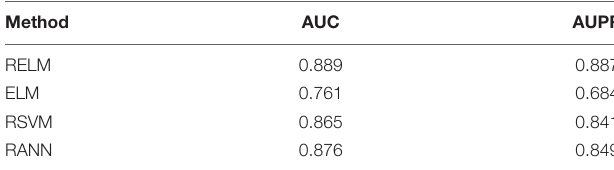
TABLE 1 | Comparison